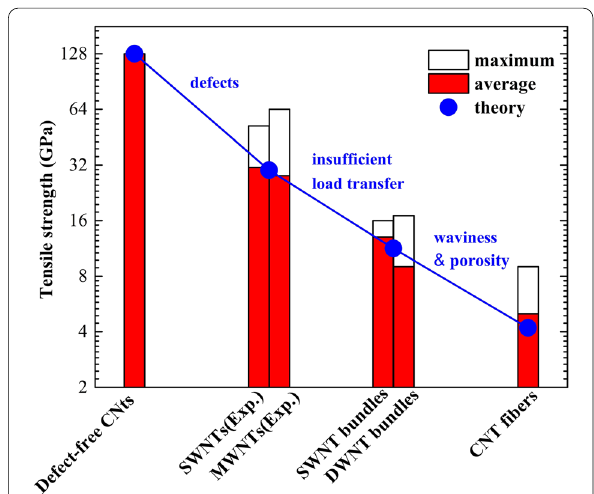
Figure 2 The strength reduction from individual, defect-free CNTs to CNT fibers